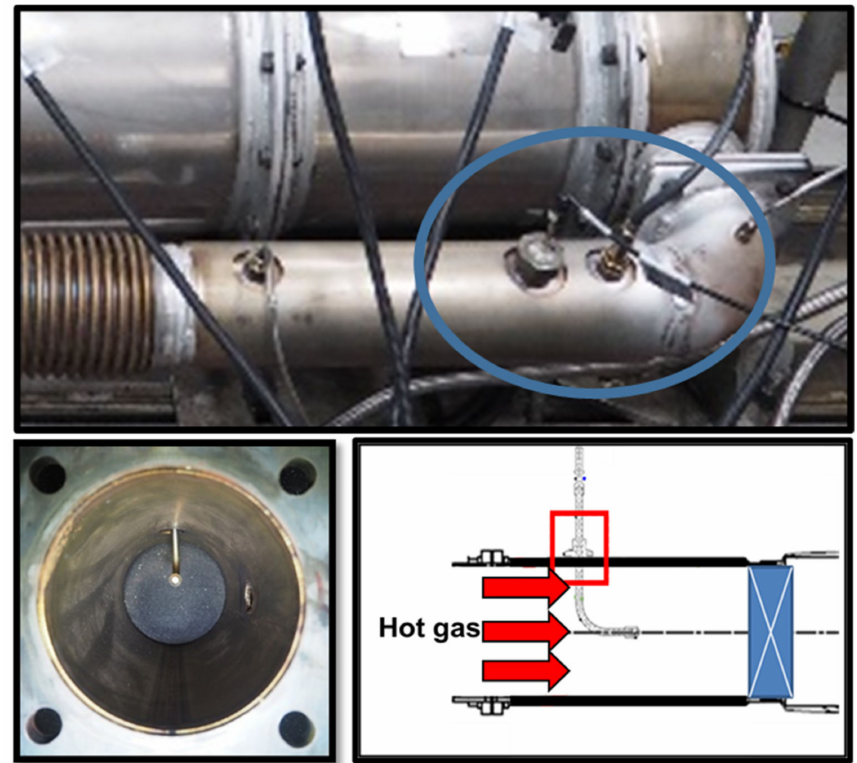
Figure 1. The original urea injector from Hyundai D6CC diesel engine.